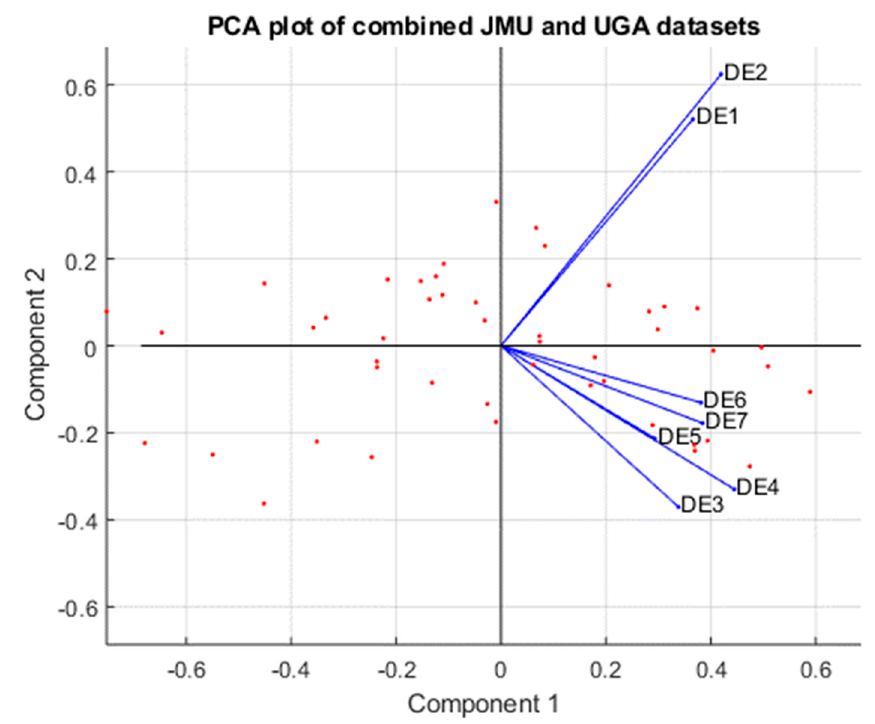
Figure 4. PCA biplot of pooled JMU and UGA dataset for design engineering attributes.